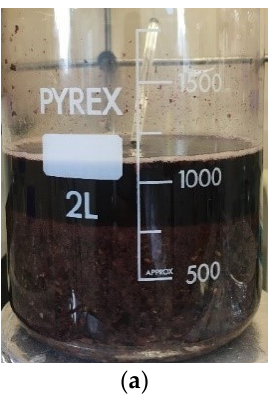
Figure 1. Large-scale Pinot noir extraction procedure: ( a ) Pinot noir pomace batch (200 g) with solvent (1 L); ( b ) filtering phenolic-enriched solvent; ( c ) centrifugation of phenolic-enriched solvent; ( d ) removal of solvent from extract.